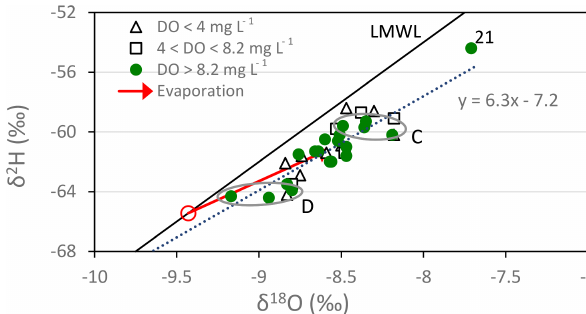
Figure 7. Paired δ 2 H and δ 18 O data in the Tinwald study area. The average initial composition of the well waters is indicated by the small red circle. Group C and Group D samples are